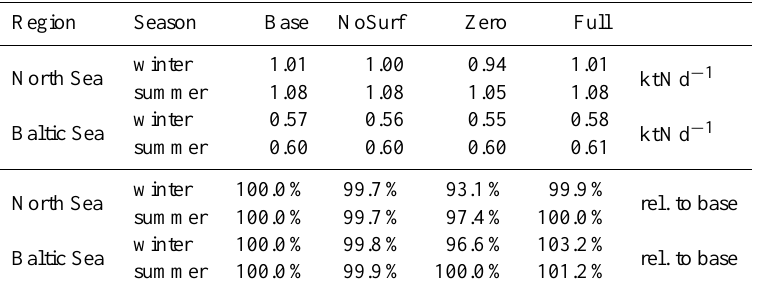
Table 6. Nitrogen deposition into the North Sea and Baltic Sea in ktNd − 1 in the base, noSurf, zero, and full cases during winter and summer. The North Sea and Baltic Sea cover 6 . 50 × 10 11 and 4 . 13 × 10 11 m 2 , respectively, in this study’s model setup. The exact regions considered are plotted in Sect. S6 of the Supplement.